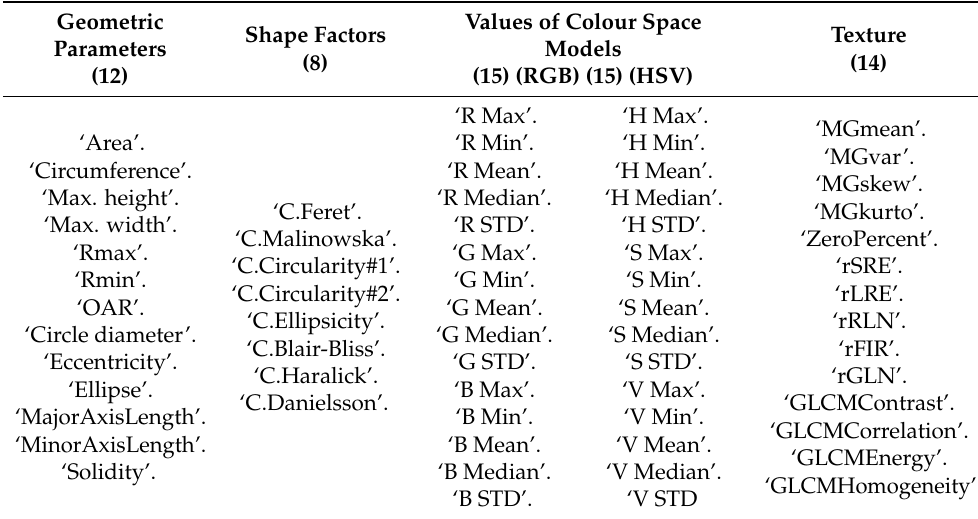
Table 2. Parameters extracted from malting barley seeds’ images using a Hordeum v.3.2 computer system (number of